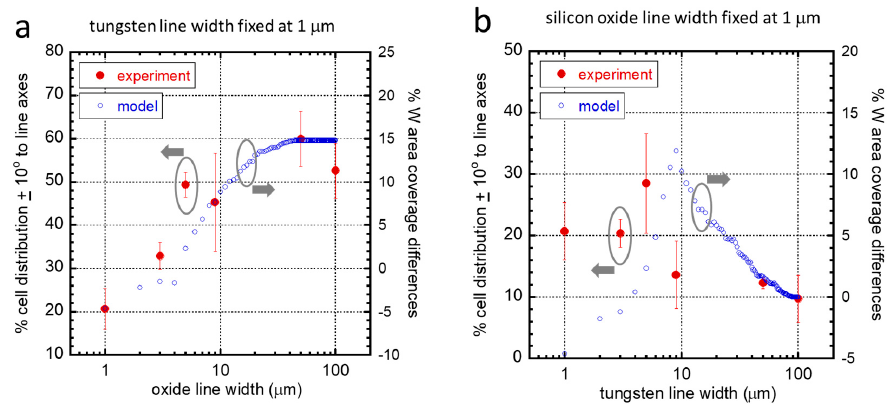
Figure 5. ( a ) Experimentally measured results of the percent distribution of cells aligned within 10 degrees of the comb structure line axes are plotted as a function of silicon oxide line widths on the left axis. The tungsten line width of these structures was fixed at 1 µm. Simulation results of the nominal tungsten coverage area differences between irregularly shaped and elongated cells are plotted on the right axis. ( b ) Comparison of experimental and model results for cells on patterns with the silicon oxide line width fixed at 1 µm and varying W line widths.